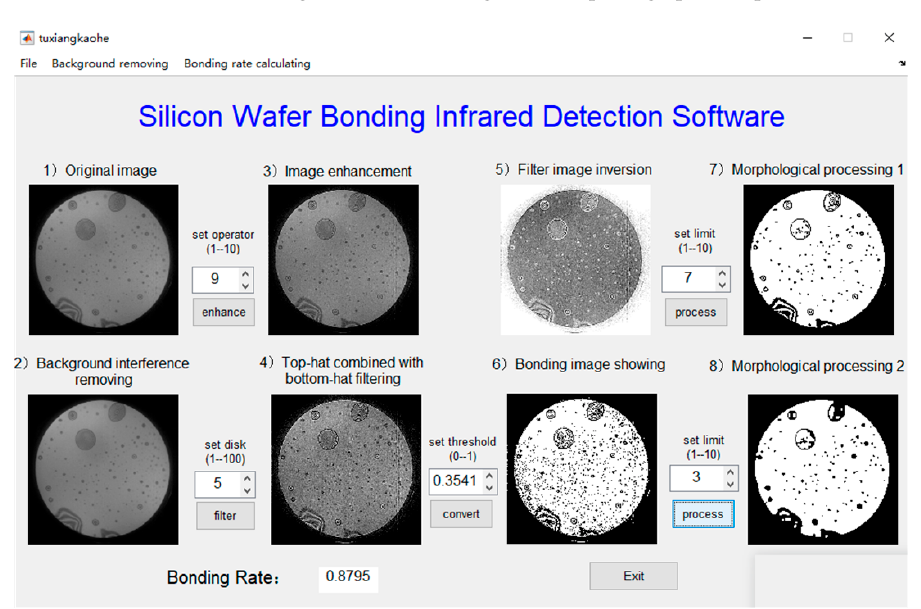
Figure 5. The analysis result of eight-neighbor sharpening operator pattern.